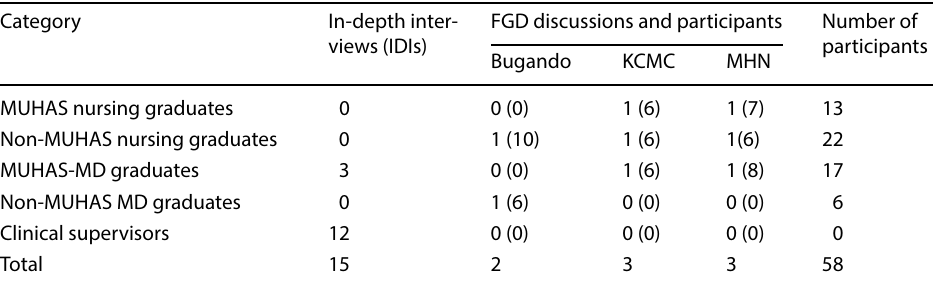
Table 1 Graduates and clinical supervisors involved in the study